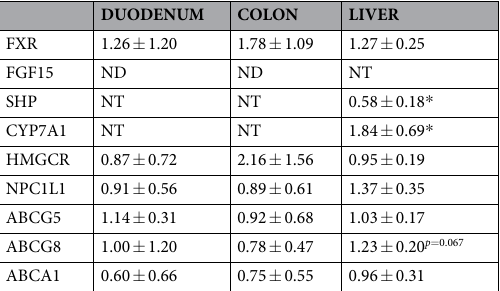
Table 3. Ratio of expression of key genes involved in bile acid and cholesterol metabolism in the HFD + P group in relation to the HFD group. Data represent the means ± SD of 6 mice per group values of p were determined using Student’s t -test where ∗ p < 0.05. Values of p compared to the HFD group are stated where appropriate. NT, not tested; ND, not